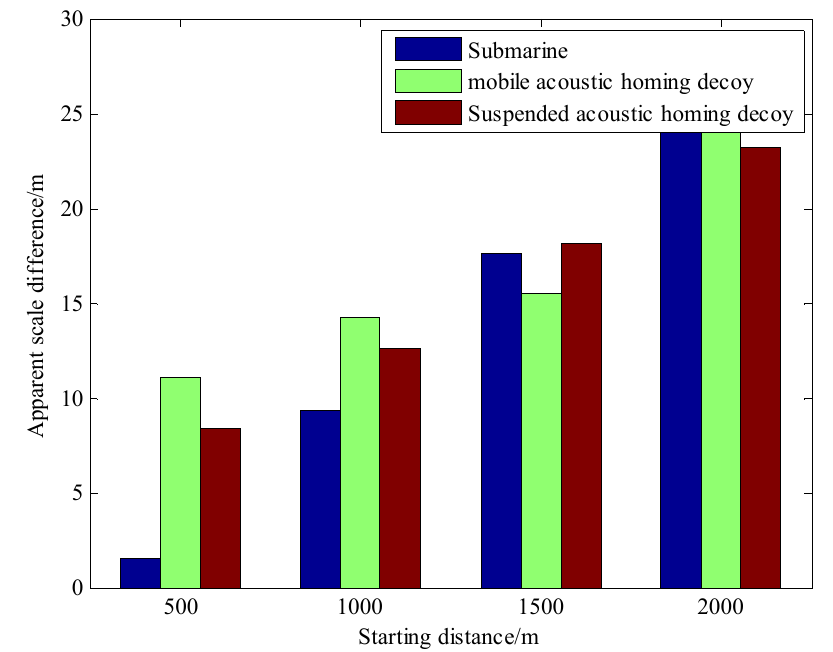
Figure 17. The apparent scale difference at different initial distances.